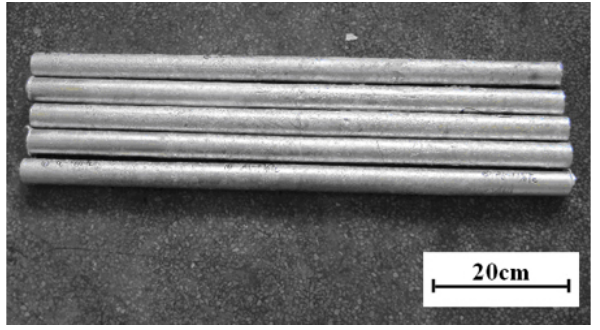
Figure 2: The photograph of Al consumable electrode.